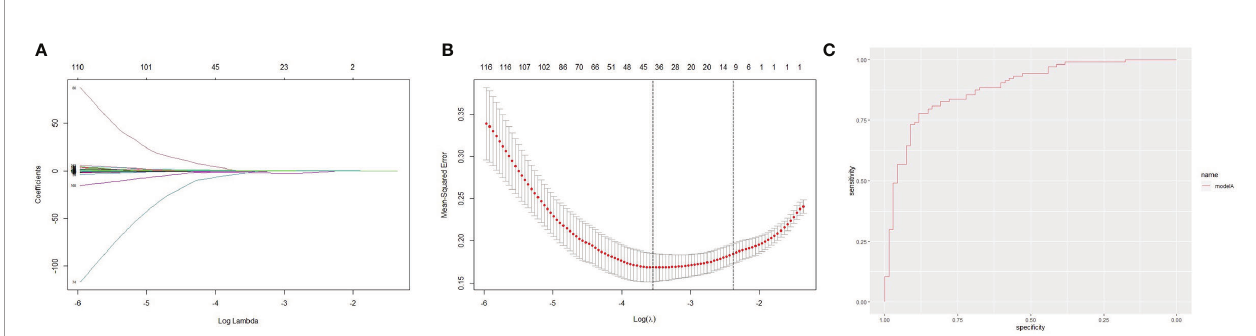
FIGURE 3 | Lasso feature selection diagram and receiver operator characteristic curve. (A) Coef fi cient diagram of least absolute shrinkage and selection operator (LASSO) variables. Each curve in the fi gure represents the trajectory of the coef fi cient of an independent variable. The x-coordinate is the logarithm function of the penalty coef fi cient l , and the y-coordinate is the mean square error. As lambda changes, the coef fi cient of the variable is compressed to zero. (B) Adjustment parameters in the LASSO model; The dotted line on the left represents the value of the l log function with the minimum mean squared error, and the right represents the best lambda log function. (C) Receiver operator characteristic curve. The AUC was 0.885 for the